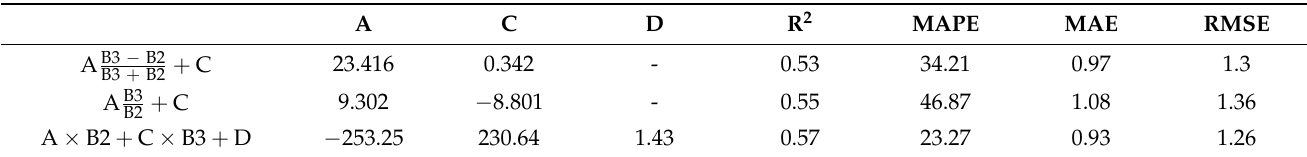
Table 3. Calibration coefficients and R 2 of empirical CDOM